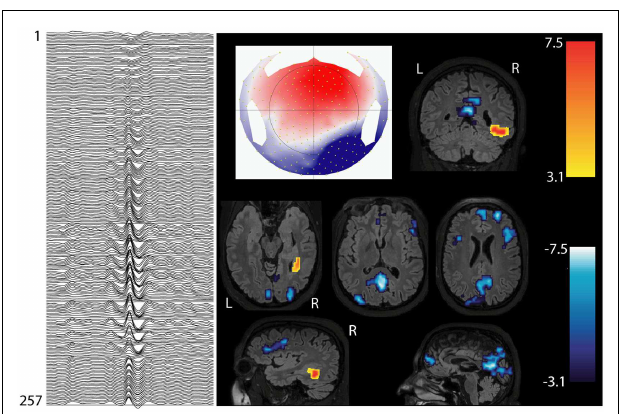
FIGURE 3 | Interictal involvement of DMN in focal epilepsy . Patients with right hemispheric extended periventricular nodular heterotopia. Marked epileptic events inside the scanner: right posterior temporal spikes with phase reversal at P8 (on the left: 256 channel EEG; referential montage Fz-Cz). BOLD increase is concordant with the spike topography (topographic map on the middle), whereas BOLD decrease is present in the regions of default-mode network